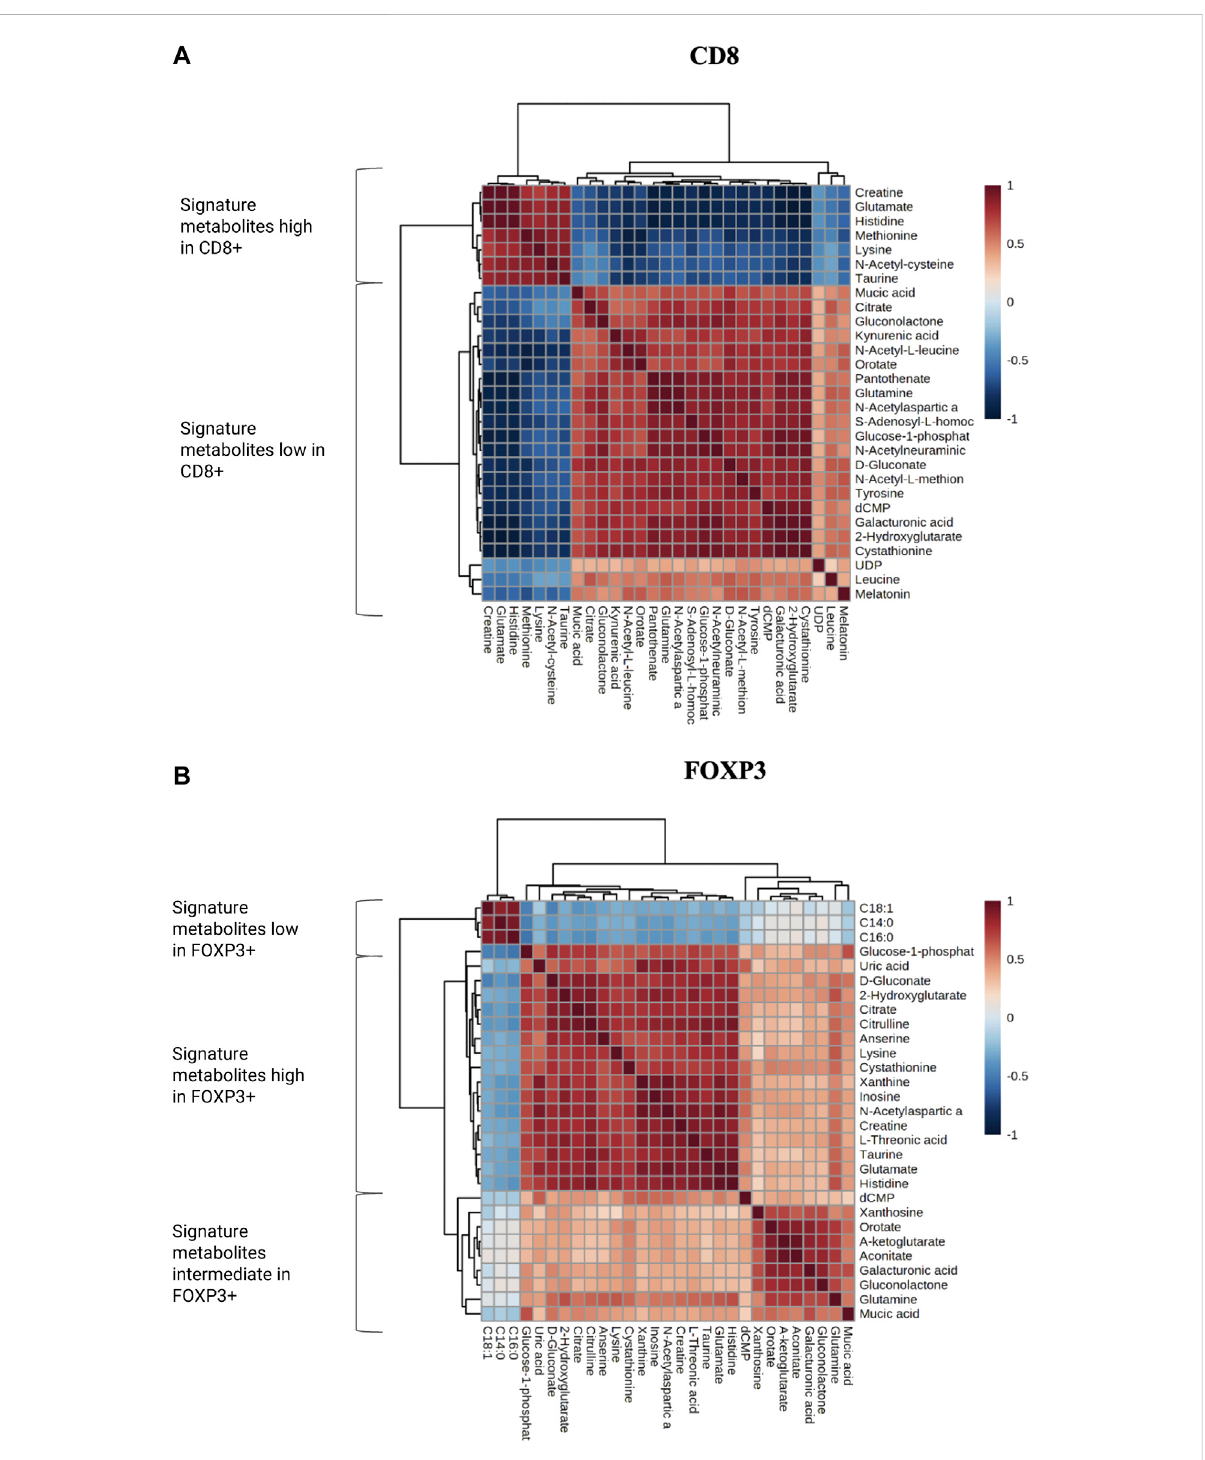
FIGURE 6 (A,B) Correlation matrixes for the most and less enriched metabolites in both CD8 + and FOXP3+ ROIs. Metabolites have been categorized in low, high and intermediate according to their abundance.